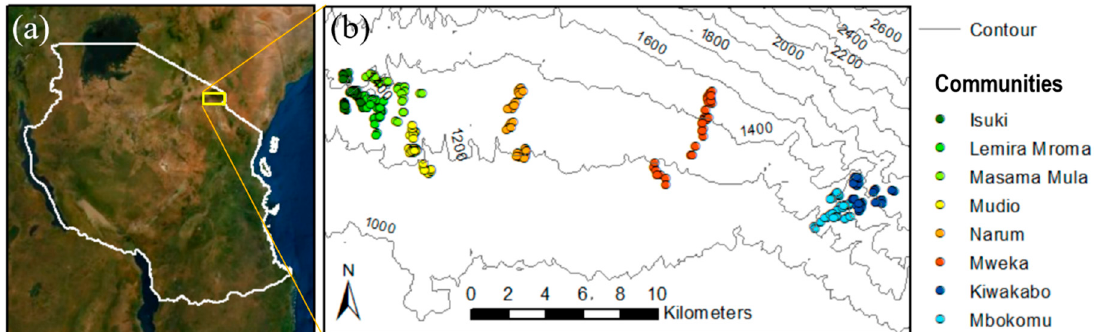
Figure 1. Location of the research area within Tanzania ( a ) and the distribution of the respondents along the southern slope of Mt. Kilimanjaro, divided into the eight communities ( b ).